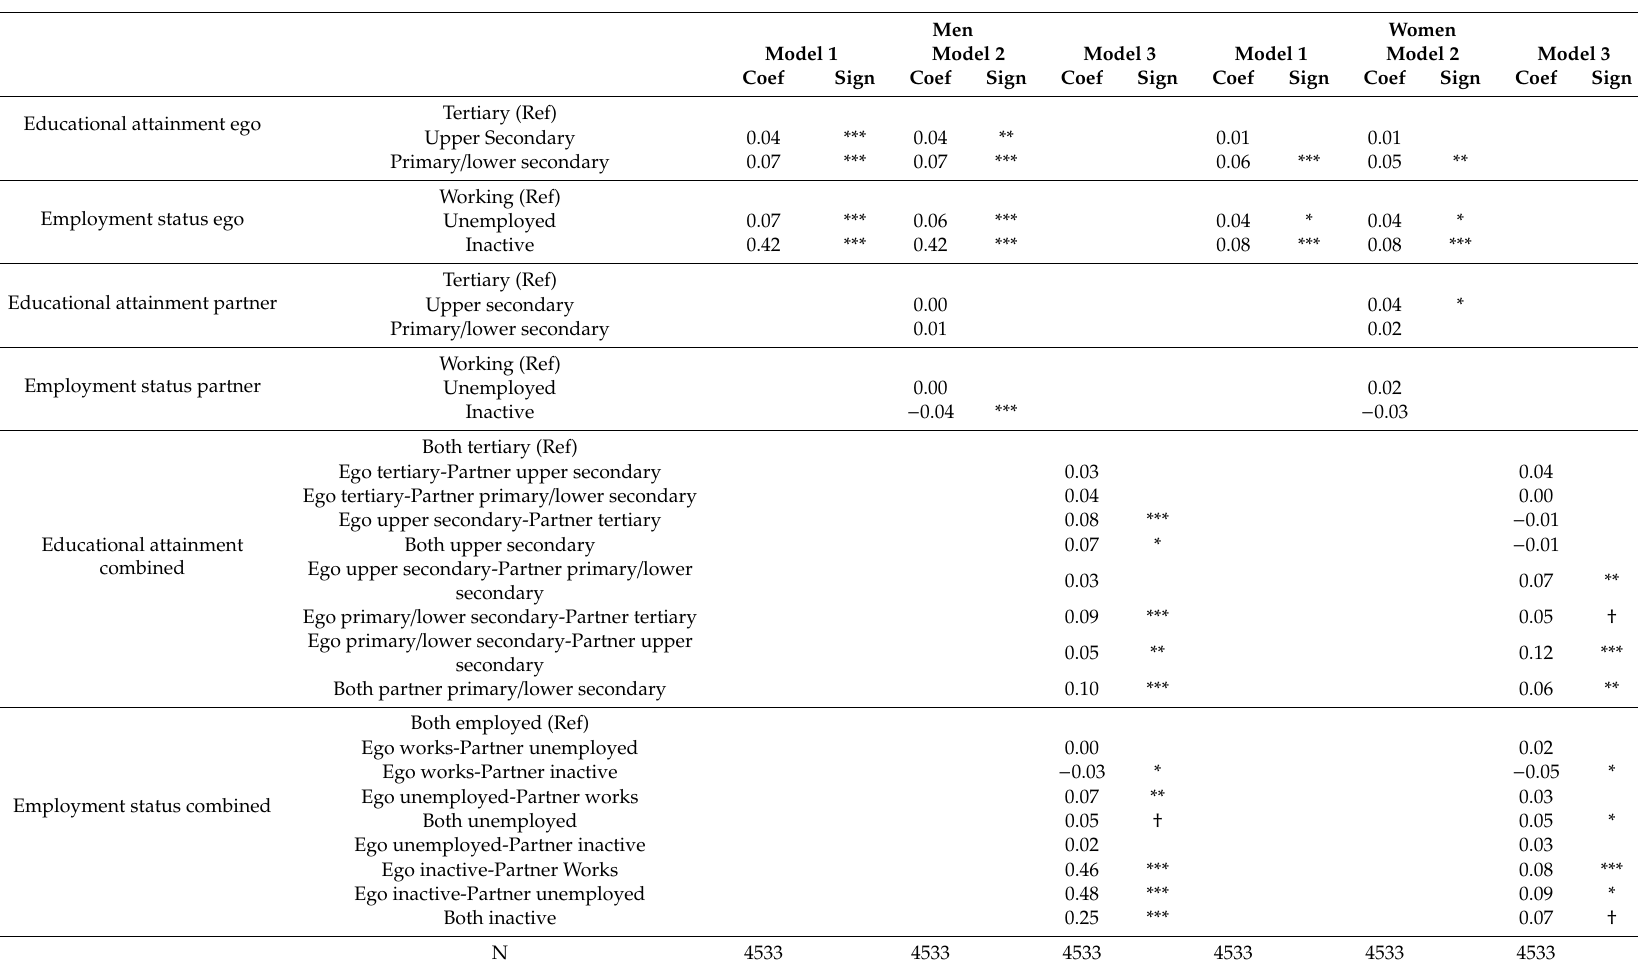
Table 5. Average marginal e ff ect from the multivariate logistic regression analysis of less than good health of couples where the oldest partner is aged 30–59. Spain